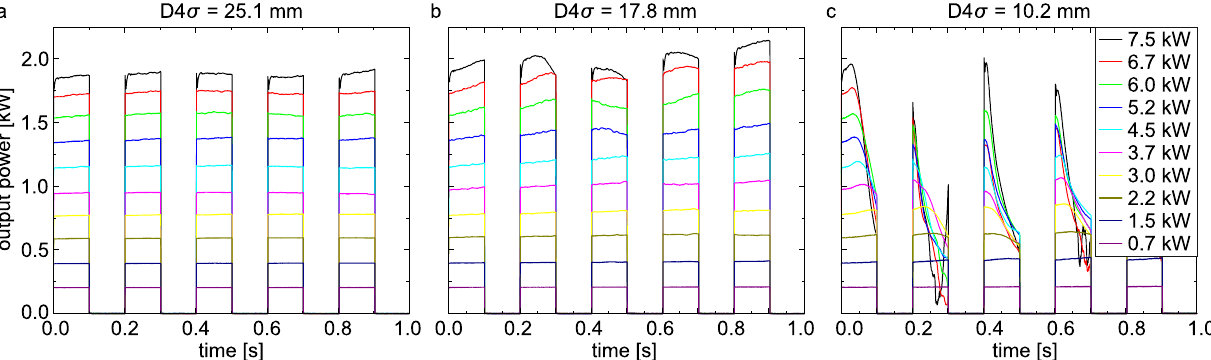
Figure 4. Output power as power in the bucket (aperture diameter 30 mm) after a water column of 10.1 cm with different laser spot sizes and input powers. For large spot sizes and low input powers, the power in the bucket is constant with time while it varies strongly for small spot sizes and high input powers. The latter arise from thermal lensing and thermal